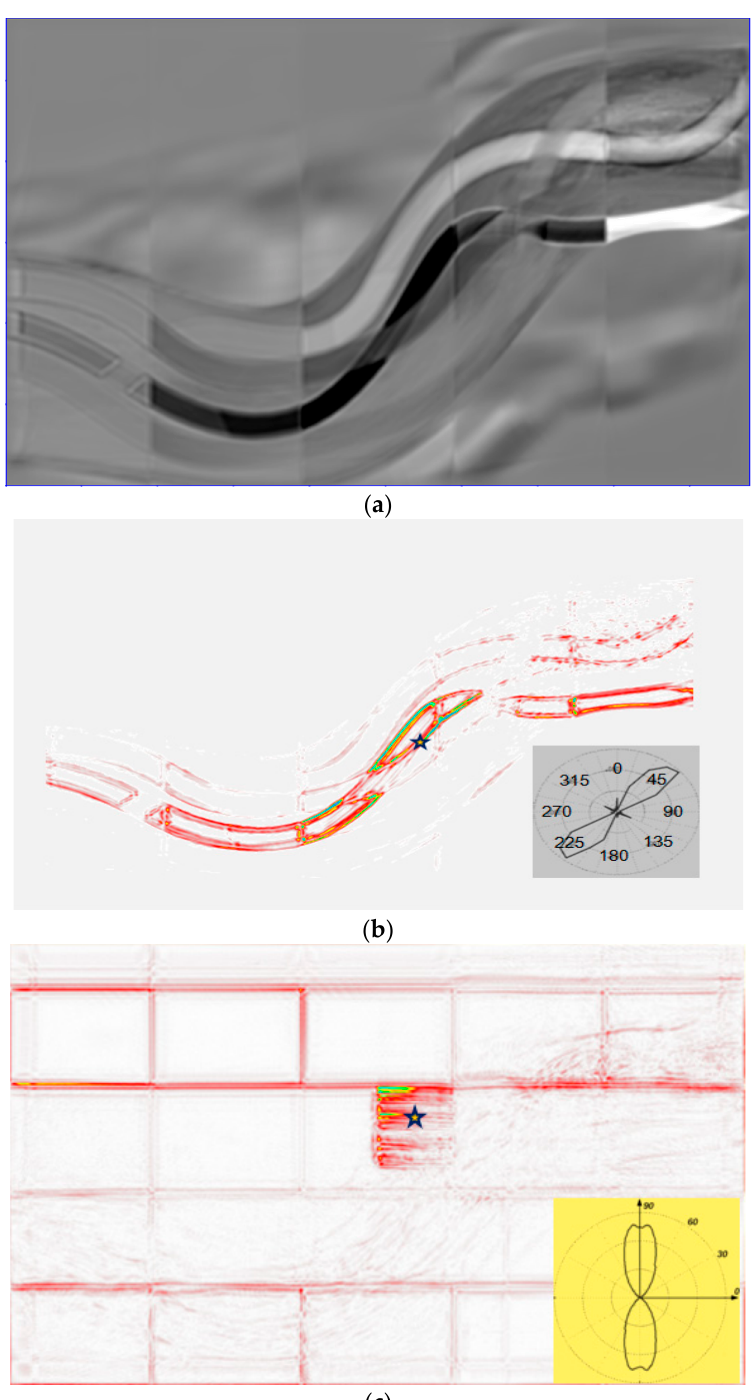
Figure 10. ( a ) Poststack time migration image at t = 0.5 s. ( b ) Poststack time domain diffraction image at t = 0.5 s. ( c ) Poststack time domain diffraction image at t = 0.84